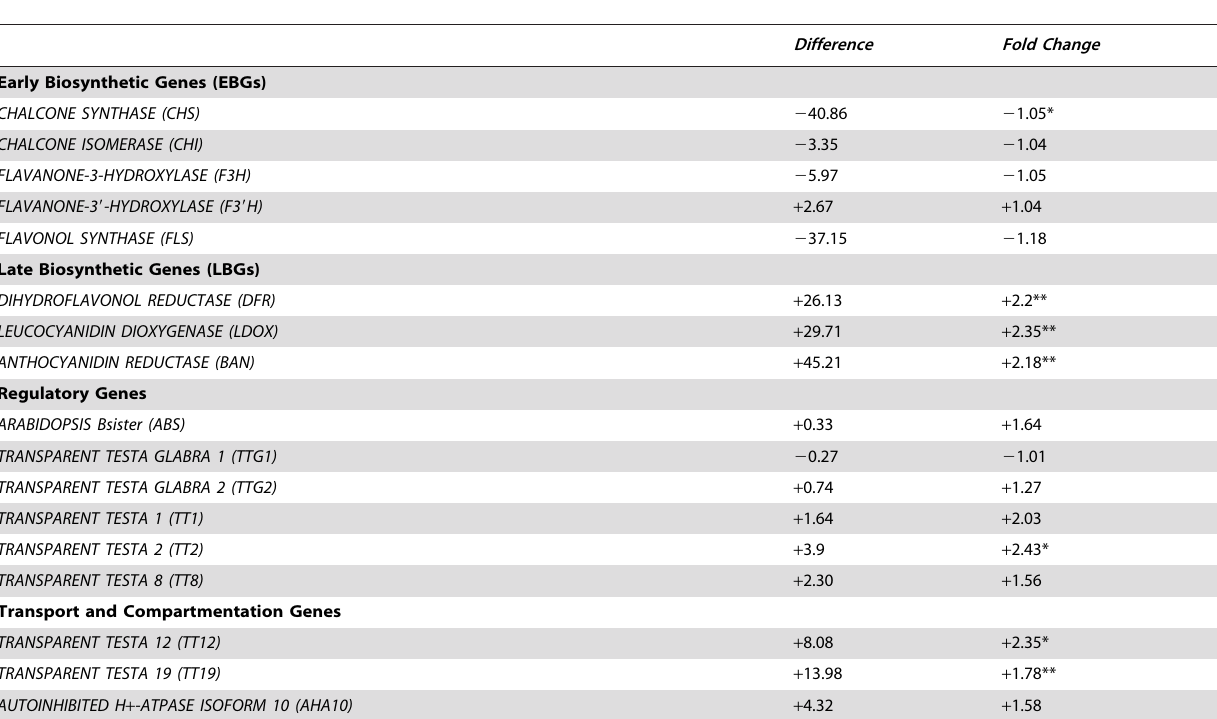
Table 1. Summary of the RNA sequencing results for the genes involved in the PA